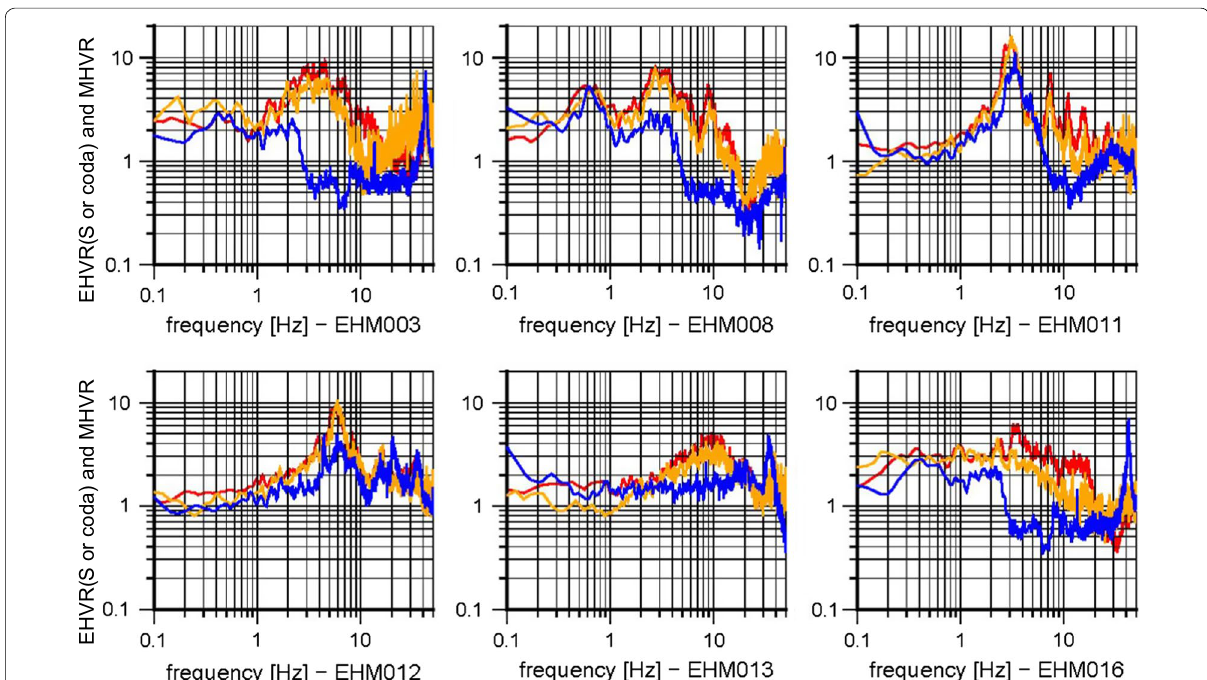
Fig. 8 Direct comparison of the average EHVRs of S-wave (red), the average EHVRs of S-coda (orange), and the average MHVRs for microtremors (blue) at six sites in Ehime Prefecture. MHVRs and EHVRs are quite similar for some sites, but MHVRs tend to be smaller for most of the sites